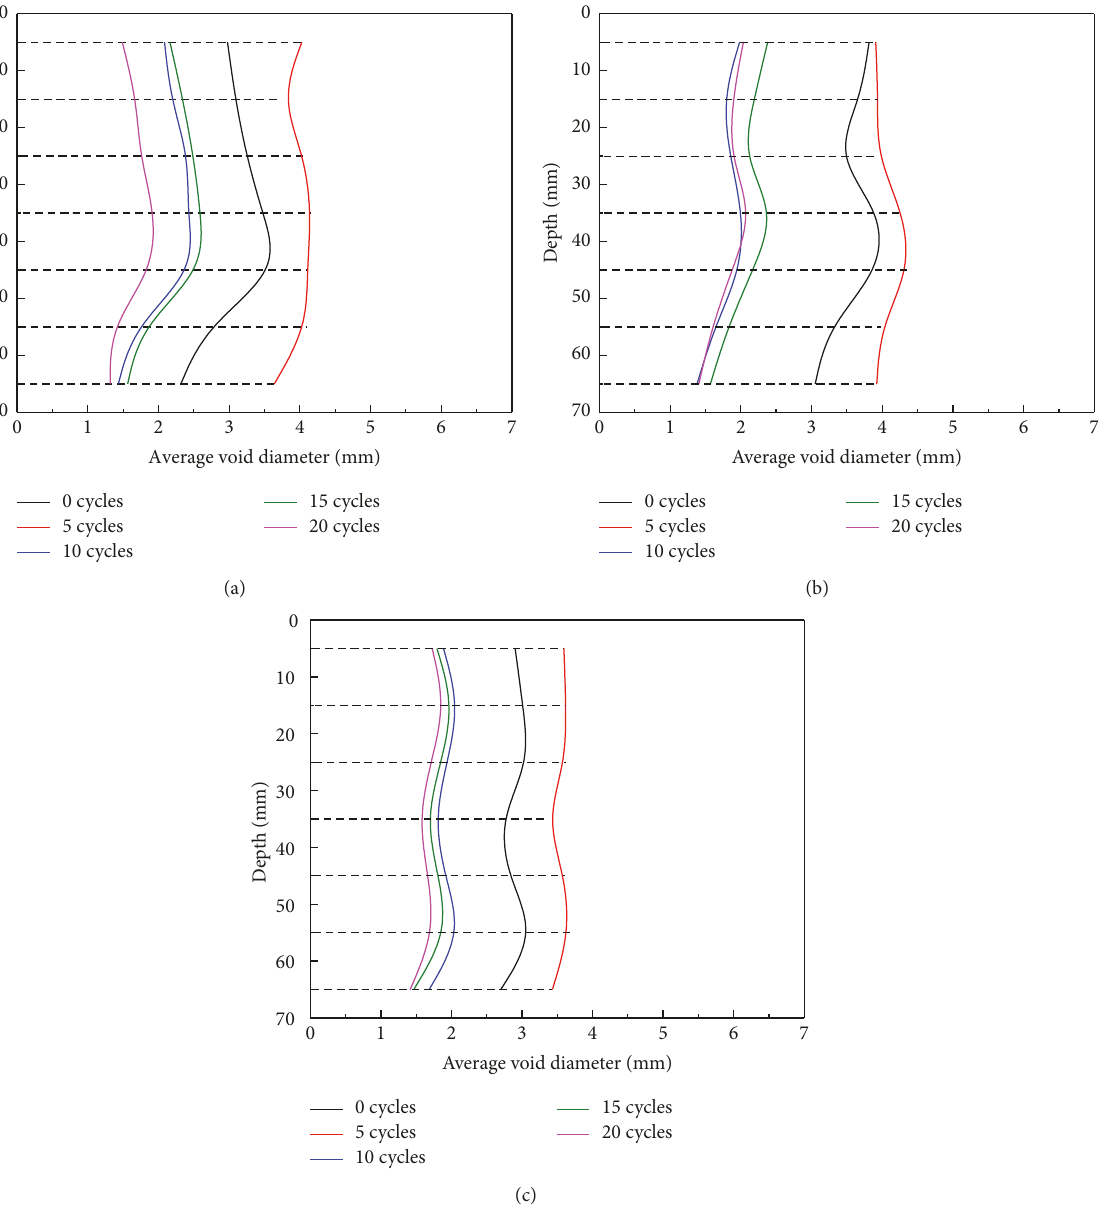
Figure 13: Average void diameter distributions of the different samples after 90 d of curing: (a) cement content = 4.0%; (b) cement content = 4.5%; (c) cement content =